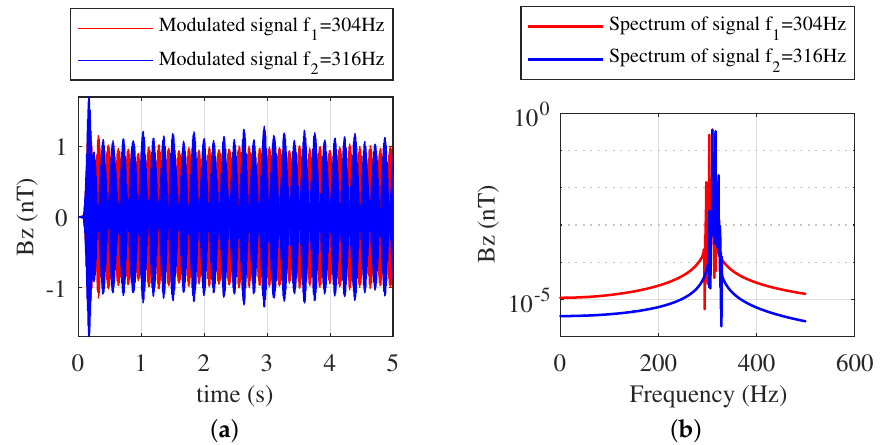
Figure 12. ( a ) Modulated signals at the point 5.4 m away from the rotating shutter antenna; ( b ) spectrum of